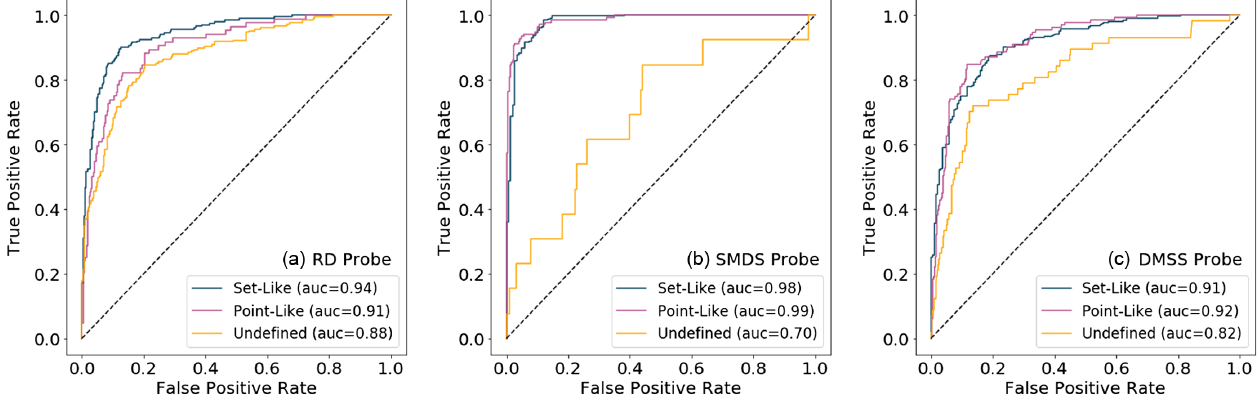
FIG. 6. ROC curves for the logistic regression classifier. After running the logistic regression algorithm on the training data for each probe, we plot our true positive rate and false positive rate from predicting classifications on the testing data. Using one-vs-all classification, each curve represents the classification of a student response as being of the labeled category, or not of the labeled category (e.g., a response being setlike or not setlike